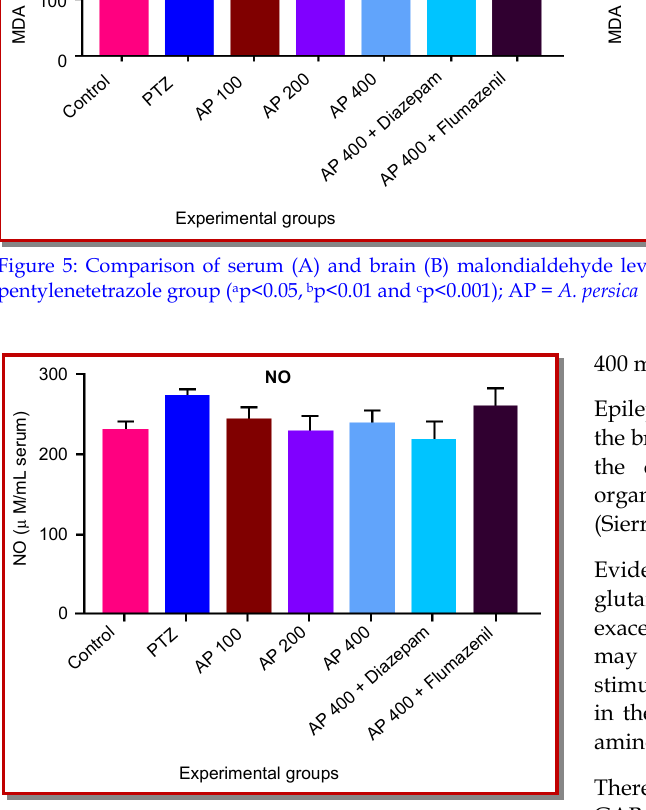
Figure 6: Comparison of serum (A) and brain (B) nitric oxide levels between groups